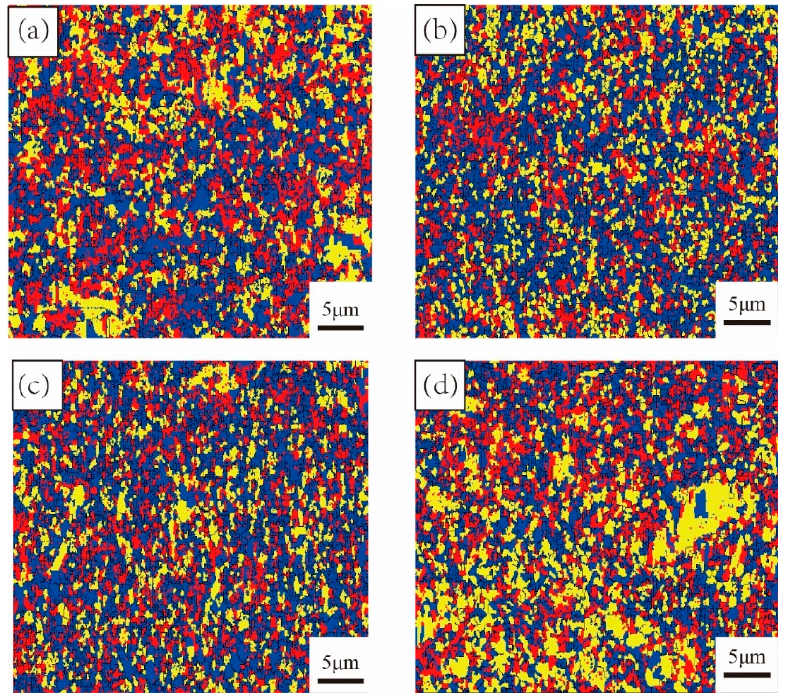
Figure 11. Recrystallization distribution of TC4 alloy after MDIF: ( a ) one cycle; ( b ) two cycles; ( c ) three cycles; ( d ) four cycles.